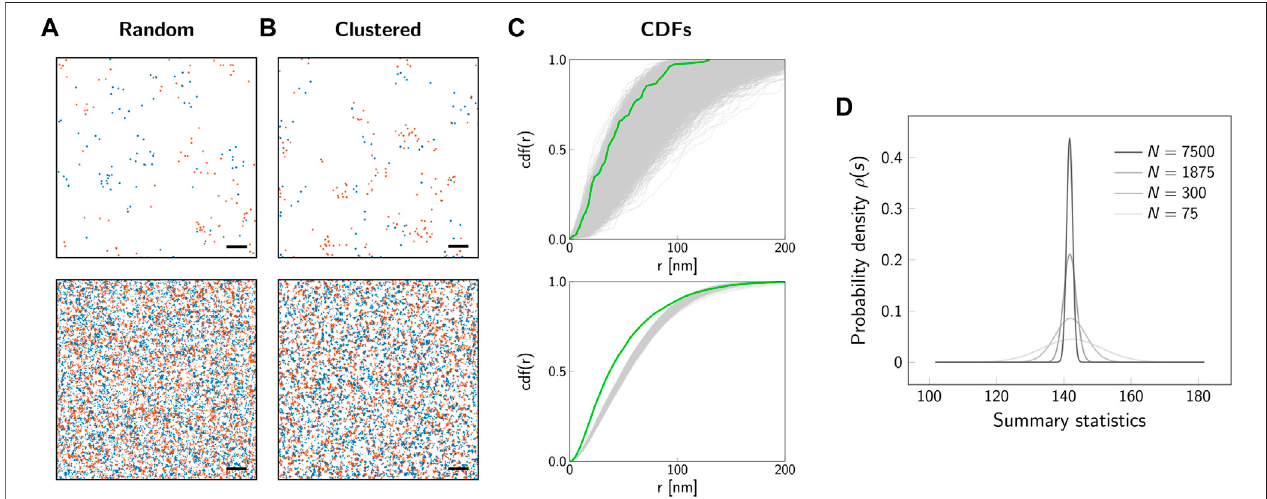
FIGURE 2 | Sampling distribution and in fl uence of sample size. Representative localization maps of an underlying random (A) and clustered (B) distribution of biomolecules. The simulated regions comprise a number of N = 75 underlying molecules (top row) or N = 7500 molecules (bottom row). For the clustered scenario, we simulated dimers. The degree of labeling was set to 100 % . Scale bars: 100 nm (top row), 1 μ m (bottom row). (C) Cumulative distribution functions (CDFs) of cross- nearest neighbor distances between localizations of the red and blue color channel. Gray lines show the CDFs for 10 000 simulations of random biomolecular distributions.ThegreenlineindicatestheCDFfortheclusteredscenariofrompanel (B) . (D) Probabilitydistribution ofthesummarystatistic,i.e.the samplingdistribution . As a summary statistic the integral of the CDF from 0 nm to 200 nm was calculated. The sampling distribution is shown for sample sizes corresponding to a number of molecules from N = 75 (light gray line) to N = 7500 (black line). The larger the sample size, the narrower is the sampling